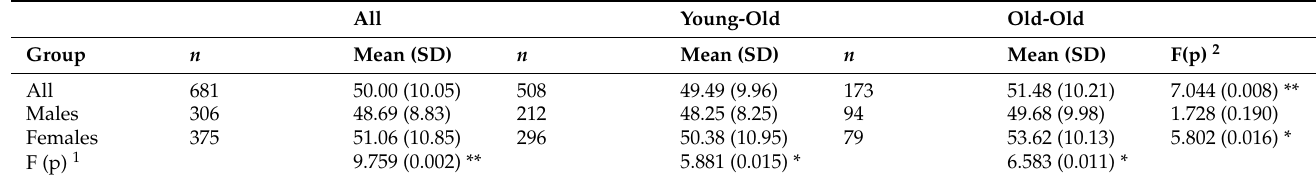
Table 2. The cross-table of mean SCD comparison between age and gender